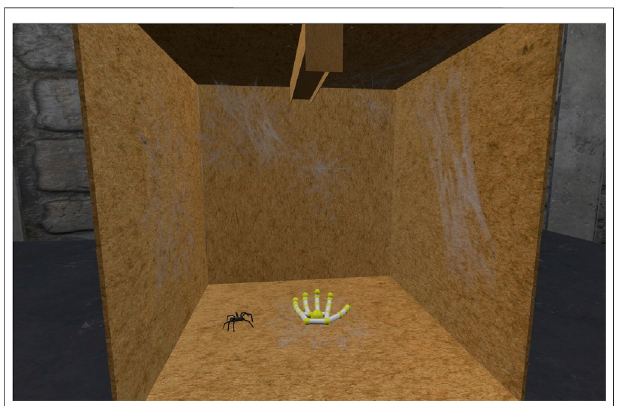
FIGURE 2 | Virtual environment, as seen by a